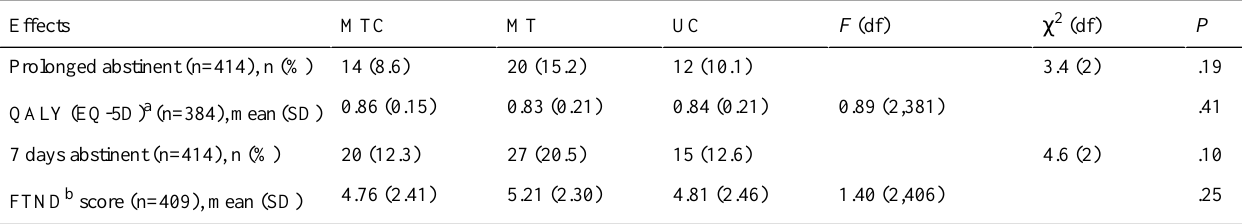
Table 3. Mean annual effect on smoking abstinence, QALY, and addiction level in the MTC, MT, and UC